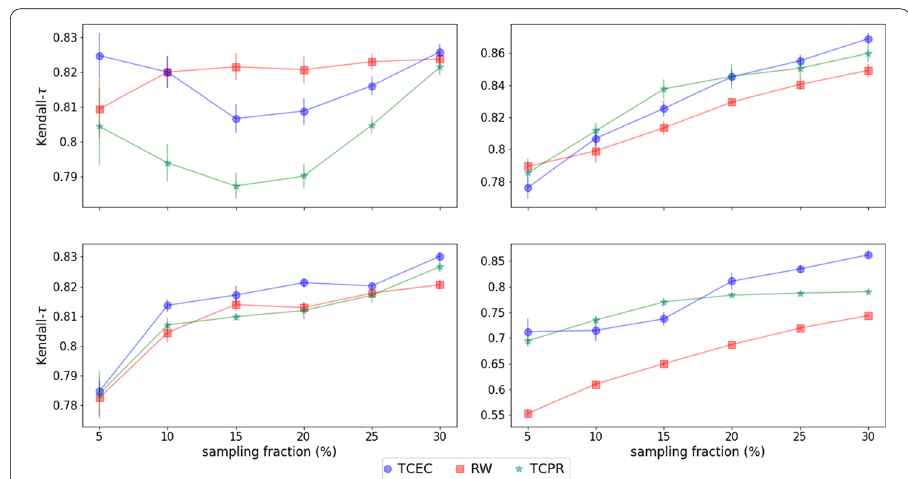
Fig. 8 Results on the four datasets for PR score approximation, respectively Epinions(upper left), Internet Topology(upper right), Slashdot(lower left) and Stanford(lower right). While, as a general trend, TCEC and TCPR seem to perform in average better than random walk for PR score estimation, there is no clear separation between the former two. Standard deviations are computed on 10 runs of